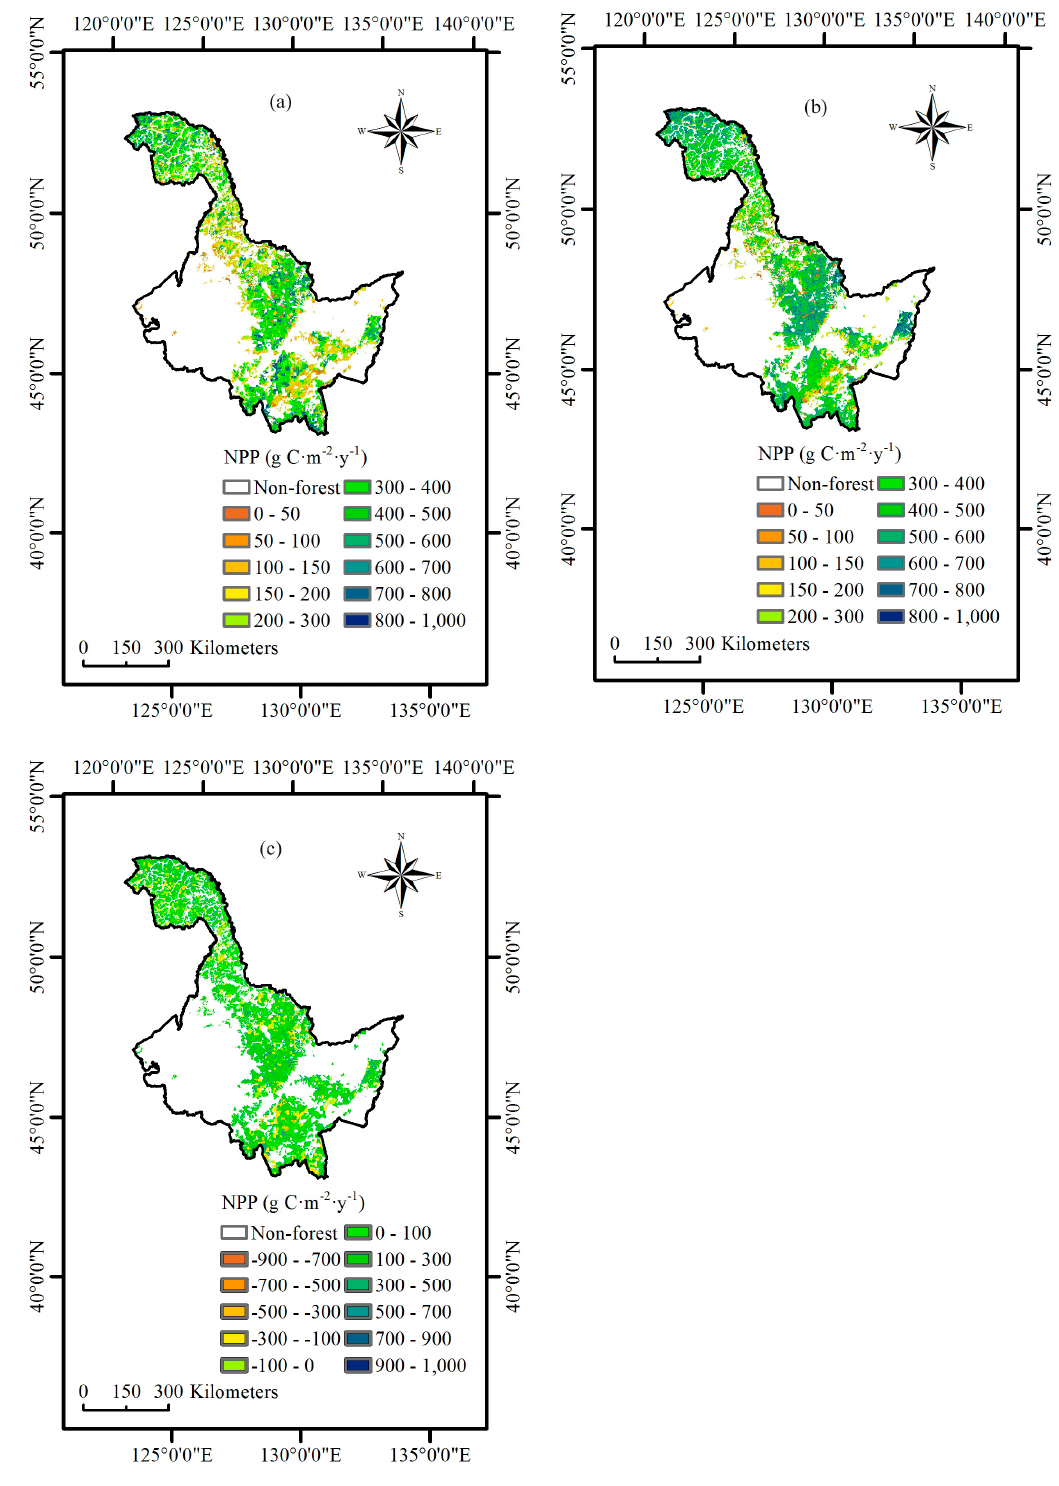
Figure 10. Comparison of NPP from the InTEC model before ( a ) and after ( b ) modification of NPP-age relationship at various SCI values. Panel ( c ) is the difference between panel ( a , b ).